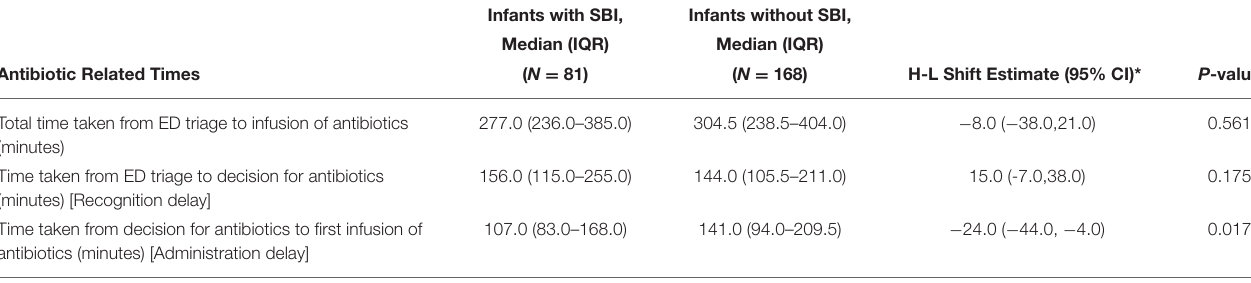
TABLE 4 | Median times related to antibiotics administration for those who received antibiotics. Infants with SBI, Infants without